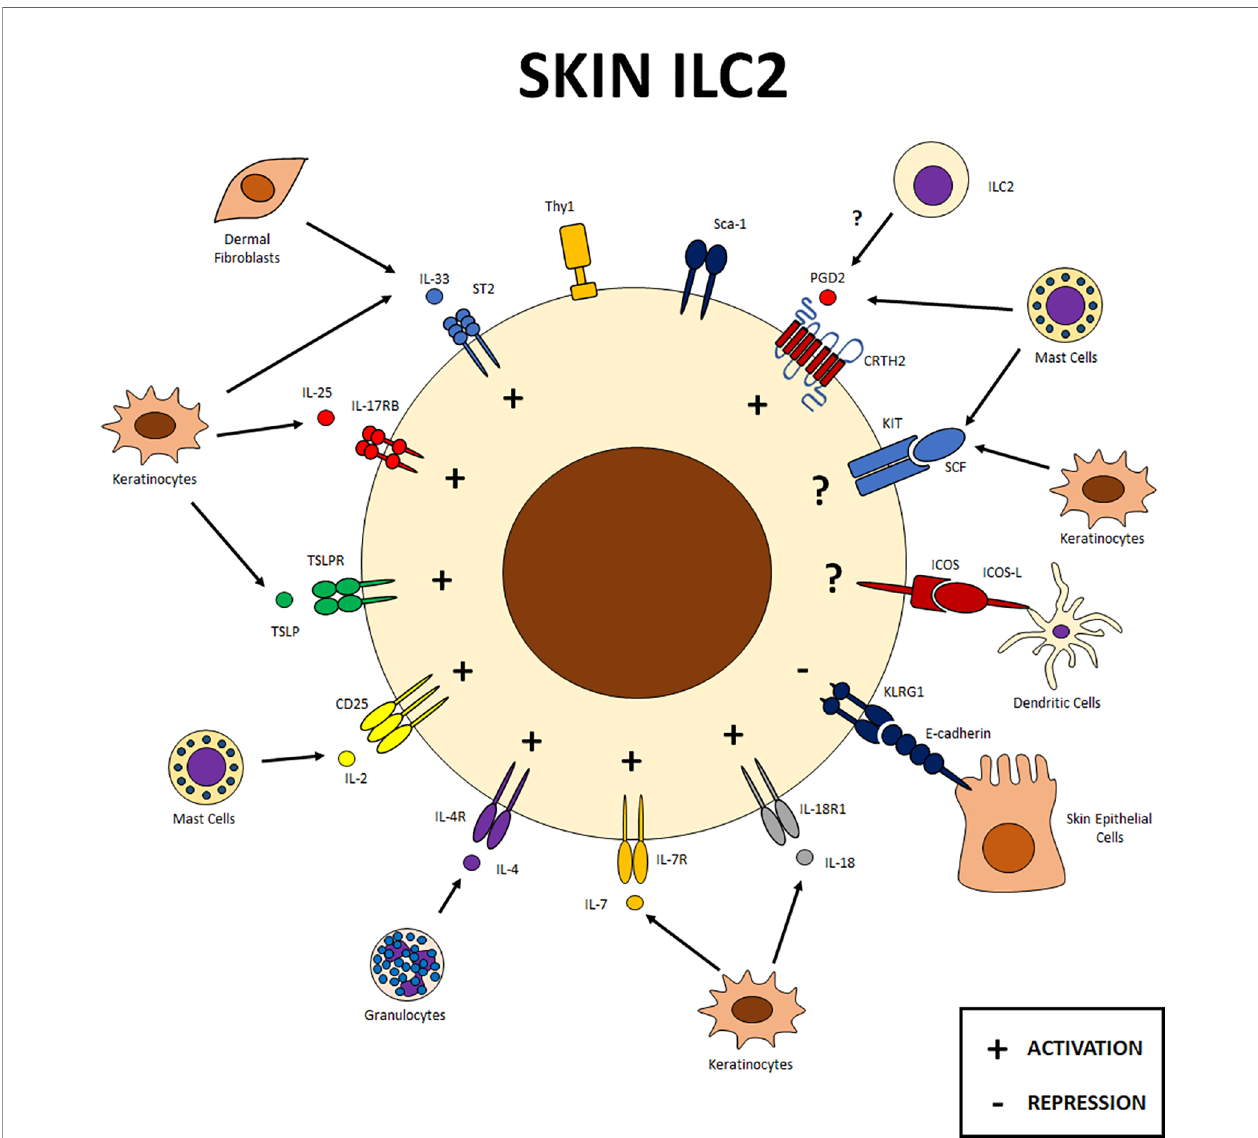
FIGURE 3 | Skin ILC2s. Expression of different receptors on skin ILC2s and cellular interactions within this tissue. ILC2s in the skin interact with different cell populations, including epithelial cells and other components of the immune system. Signals from IL-33, IL-25, TSLP, IL-2, IL-4, IL-7, IL-18 and PGD2 receptors favor ILC2 function in this tissue. Klrg1 on ILC2s can interact with E-cadherin to negatively regulate these cells in the skin. Other receptors such as KIT and ICOS have also been reported in skin ILC2s although their speci fi c function has yet to be determined. SCF, stem cell factor; PG, prostaglandin; LT,